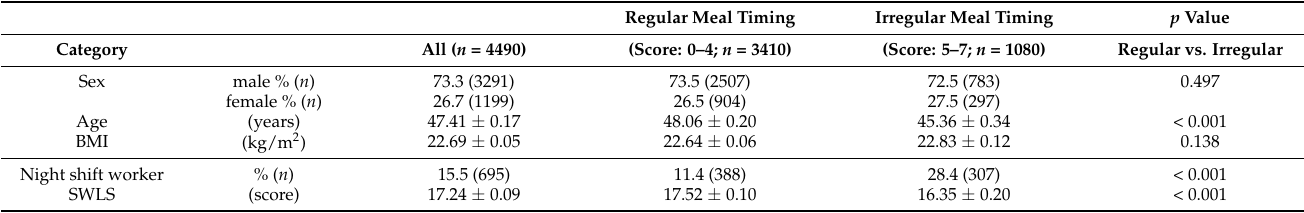
Table 1. Participants’